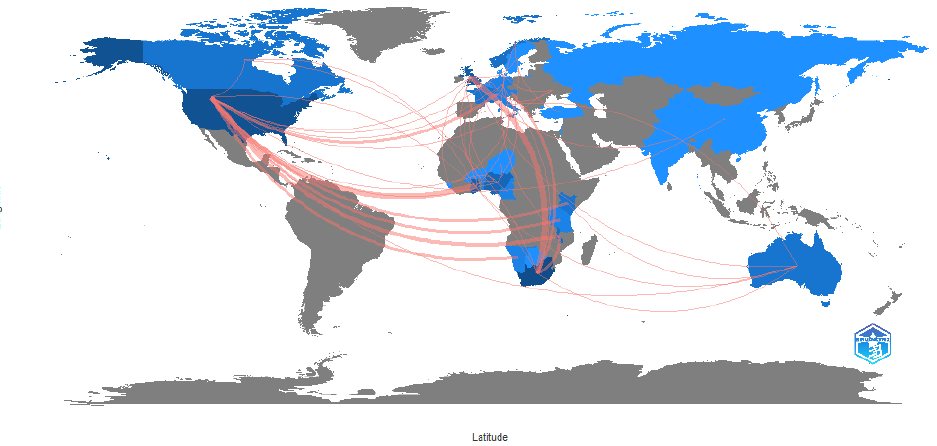
Figure 4. Country collaboration map: African related studies. Source : Author’s own, based on Web of Science search.